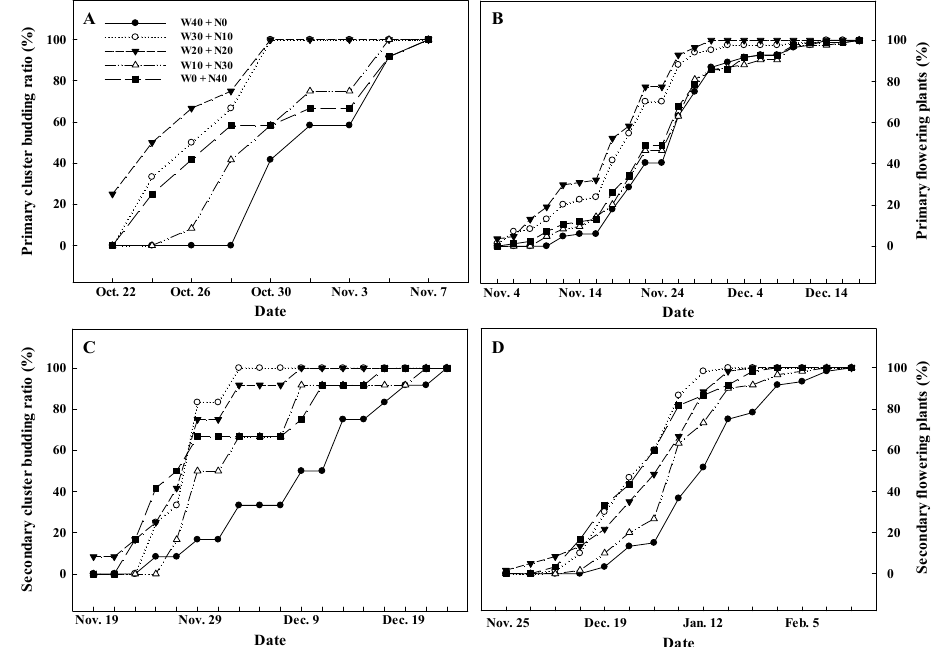
Figure 3. The primary cluster budding ratio ( A ), primary flowering plants ( B ), secondary cluster budding ratio ( C ), and secondary flowering plants ( D ) of “Maehyang” strawberries affected by the nutrient solution resupply period during the nursery stage. Refer to Figure 1 for details on nutrient solution resupply periods.